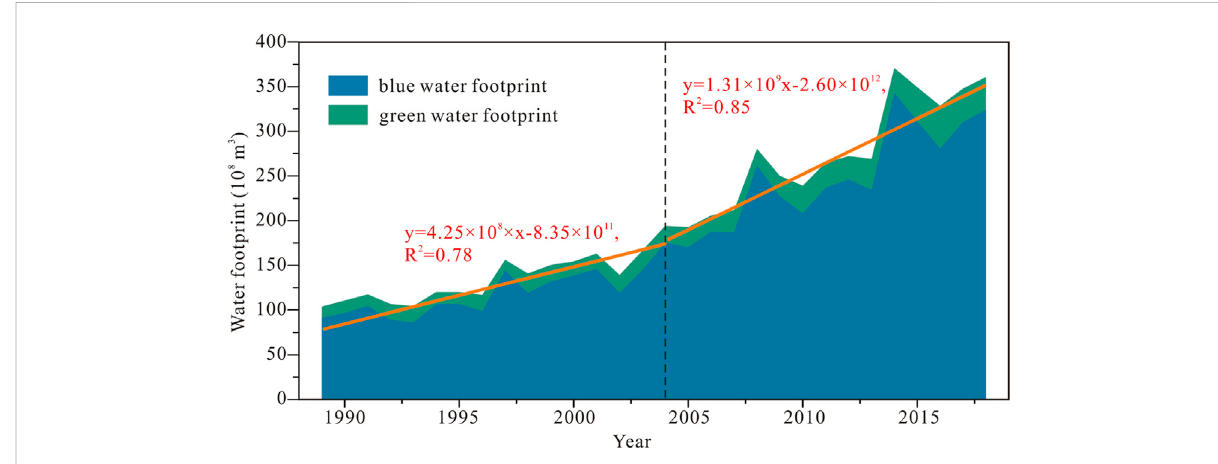
FIGURE 2 Changes in WF of crop in Xinjiang from 1989 to 2018: the overall trend accumulated by blue and green WF.